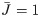
Graphical solution of the bump amplitude Eq (50) for J¯=1 and η = 0.5.At intermediate gains (γ = 4) the zero solution is unstable and there exists a single stable bump. In the high gain limit (γ = 20) the zero solution is stable, and coexists with a small amplitude unstable bump and a large amplitude stable bump.